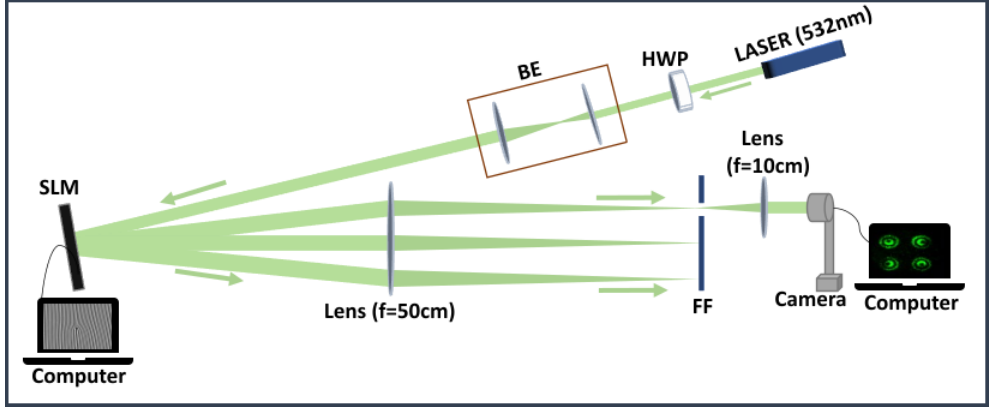
Figure 5. Schematic of the optical setup used for practical generation of asymmetric LG beam array. (BE: Beam expander; SF: Spatial filter; HWP: Half wave plate; SLM: Spatial light modulator).